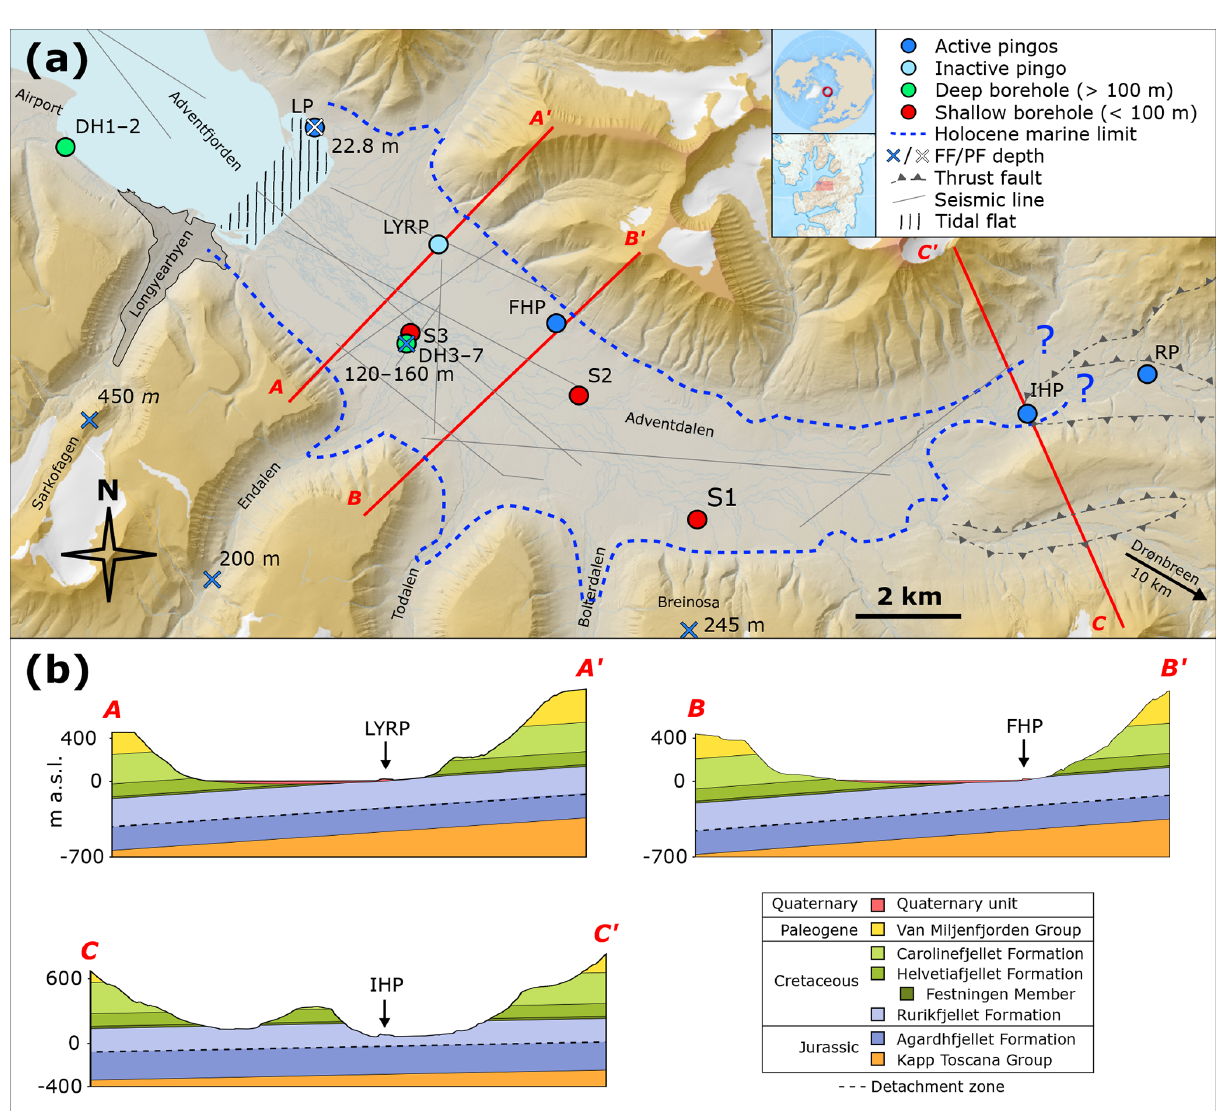
Figure 2. (a) Map of lower Adventdalen with the location of data resources, pingos and the Holocene marine limit. LP: Lagoon Pingo; LYRP: Longyear Pingo; FHP: Førstehytte Pingo; IHP: Innerhytte Pingo; and RP: River Pingo. Core logs from boreholes S1–3 and D1–D7 (respectively, Gilbert et al., 2018, and Olaussen et al., 2020, and references therein), seismic lines (Bælum et al., 2012, and unpublished com- mercial lines from Norsk Hydro), and a geological map (Norwegian Polar Institute, 2019) were used to build the geological model (Fig. 5a) (see details in Hornum, 2018). Permafrost depth measurements at the Sarkofagen, DH4 and Breinosa sites are from Liestøl (1977), Braathen et al. (2012), and Christiansen et al. (2005), respectively. The freezing front depth at LP is from Yoshikawa and Harada (1995). Data used to develop the map including topography, glacial extent and fluvial network are courtesy of the Norwegian Polar Institute (2019). (b) Geolog- ical cross sections constructed based on the resources mentioned above. The Quaternary unit overlies well-consolidated sedimentary strata of pre-Cenozoic age (i.e. Cretaceous or older). See Sect. 3.1 for a (hydro)geological description of the layers shown in cross sections A, B and